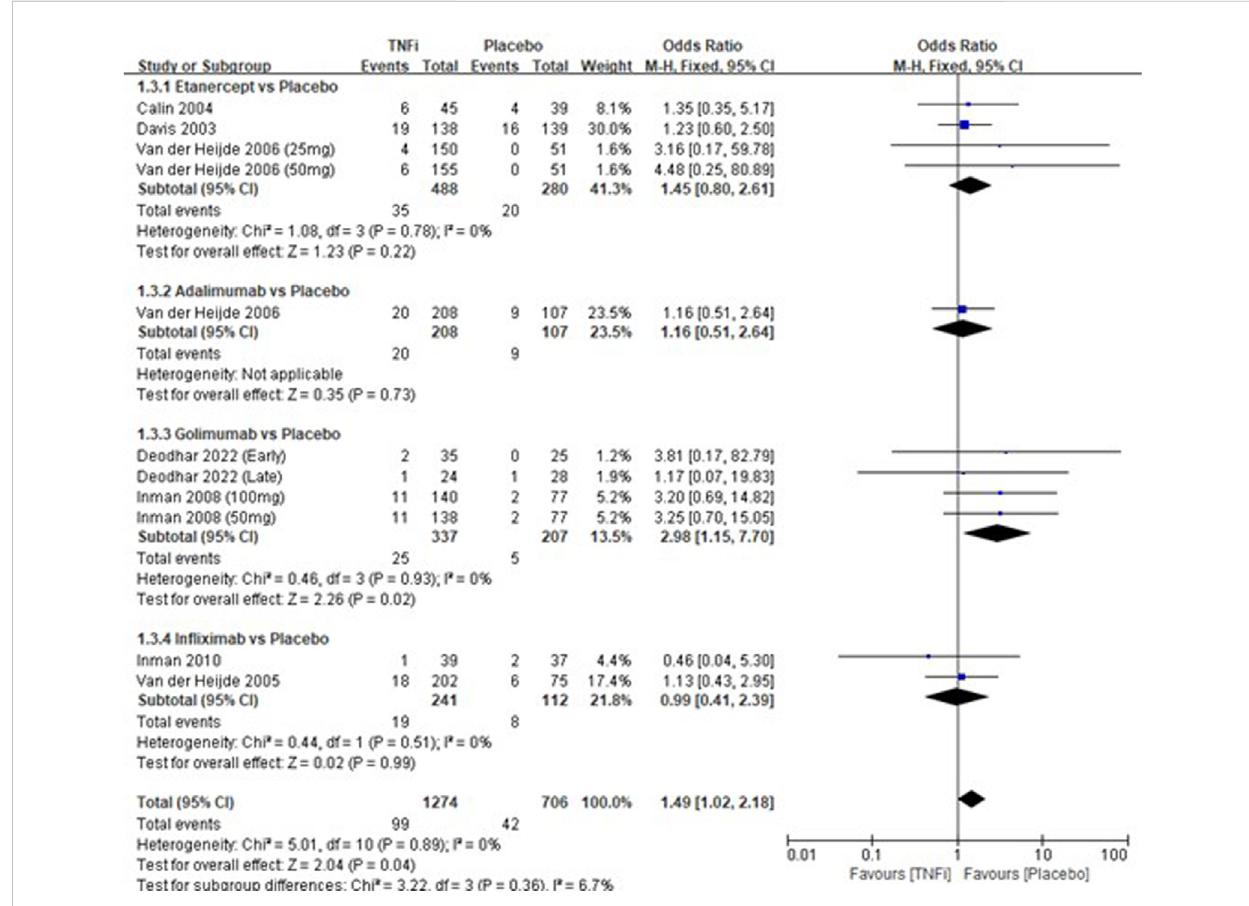
FIGURE 4 Pooled estimate of the incidence of headache between TNFi and placebo groups in patients with ankylosing spondylitis. The odds ratio > 1.0 indicates that the incidence of headache is higher in the TNFi group than that in the placebo group. The subheading “ Events ” refers to the number of incidences of headache. “ Total ” refers to the total number of individuals. CI, con fi dence interval; df, degrees of freedom; M-H, Mantel – Haenszel method of